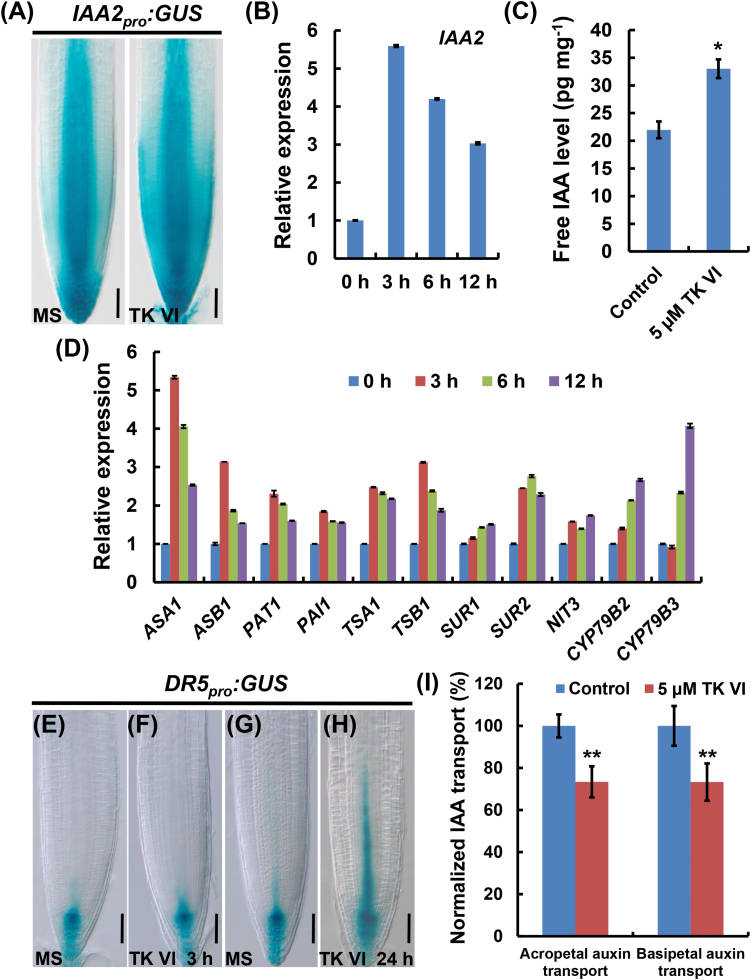
TK VI-induced increase of auxin content and alteration of auxin response gradients in the Col-0 root tip. (A) TK VI-induced enhancement of IAA2
pro
:GUS expression in the Col-0 root tip. Six-day-old seedlings were transferred to medium without (MS) or with 5 μM TK VI for 12h before GUS staining. (B) Time course of expression of IAA2 in response to TK VI treatment. (C) Free IAA measurement in Col-0 root tips in response to TK VI treatment. Six-day-old Col-0 seedlings were transplanted to medium without (Control) or with 5 μM TK VI for 3h before the 2mm root tips were harvested. Free IAA levels were then measured. The error bars represent the SD of triplicate measurements. The asterisks denote Student’s t-test significance compared with untreated plants: *P<0.05.(D) Time course of expression of auxin biosynthesis-related genes in response to TK VI treatment. For (B) and (D), 6-day-old Col-0 seedlings were treated with 5 μM TK VI for the indicated time periods, and the 2mm root tips were harvested for RNA extraction and qRT–PCR analysis. Transcript levels of the indicated genes in Col-0 without TK VI treatment were arbitrarily set to 1. The error bars represent the SD of triplicate reactions.(E, F, G, H) TK VI-induced disturbance of DR5
pro
:GUS expression in the Col-0 root tip. Six-day-old seedlings were transferred to medium without (MS) or with 5 μM TK VI for the indicated times before GUS staining. (I) TK VI-induced repression of acropetal and basipetal auxin transport. Six-day-old Col-0 seedlings were transplanted to medium without (Control) or with 5 μM TK VI for 24h before acropetal and basipetal auxin transport assays were performed. The acropetal and basipetal auxin transport levels without TK VI treatment were arbitrarily set to 100%. Data shown are mean values of five biological repeats with the SD. The asterisks denote Student’s t-test significance compared with untreated plants: **P<0.01. Scale bars=50 µm (A, E, F, G, H).